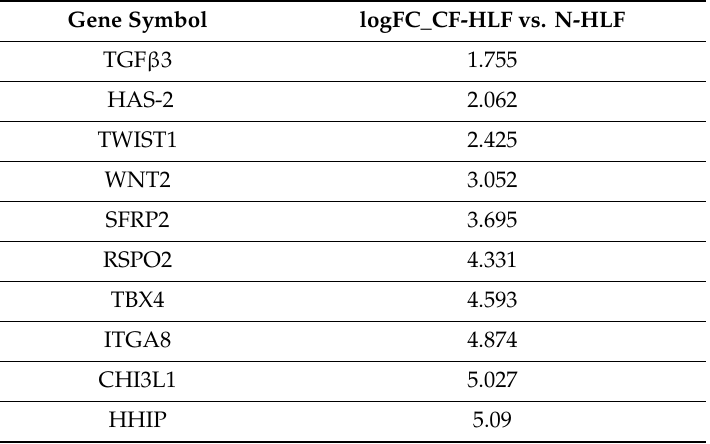
Table 4. Up-regulated genes from the 3D dataset (CF-HLF vs.